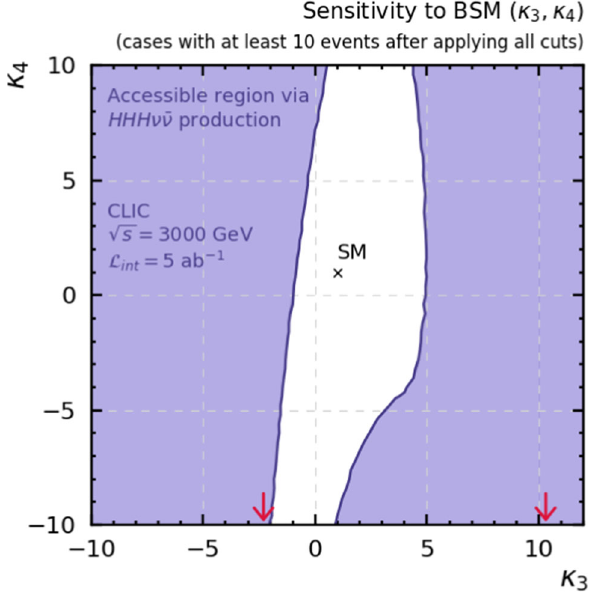
Fig. 37 Accessible region in the ( κ 3 ,κ 4 ) plane to BSM scenarios via e + e − → H H H ν ¯ ν → b ¯ bb ¯ bb ¯ b ν ¯ ν events at CLIC, with GeV and L int = 5 ab − 1 . The criterion of accesibility assumed here is requiring more than 10 signal events (purple area). The red arrows mark the limits of the present bound from ATLAS [3] for κ 3 , given in Eq.